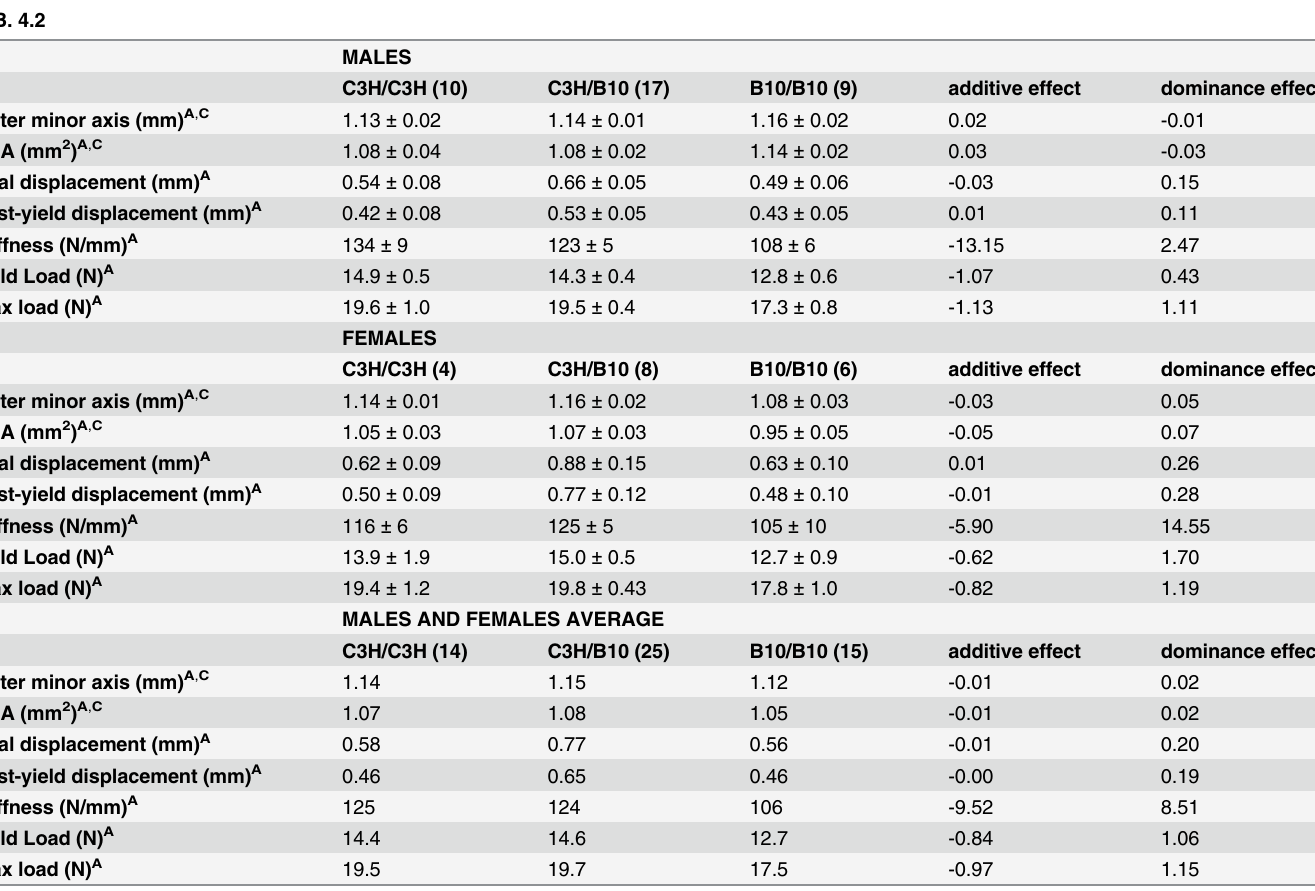
Table 7. Additive and Dominance Effects for Chromosome 4 QTL in C.B.4.2